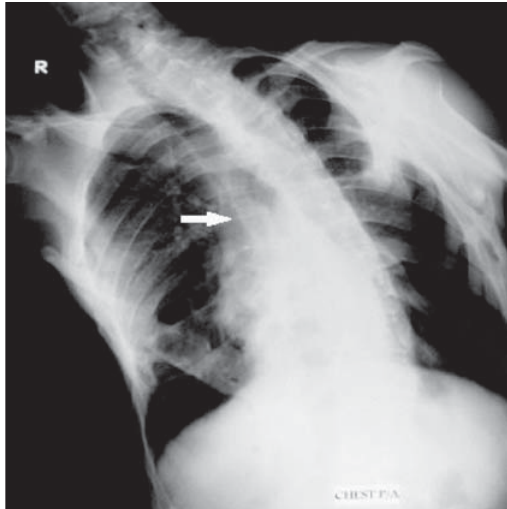
Fig 5. X-ray pelvis AP view showing extensive ligamental and right paravertebral ossifi- cation (white arrow). Intervertebral disc calcification is apparent. Right sided osseous bridge is evident between the ilium and sacrum (black arrow).